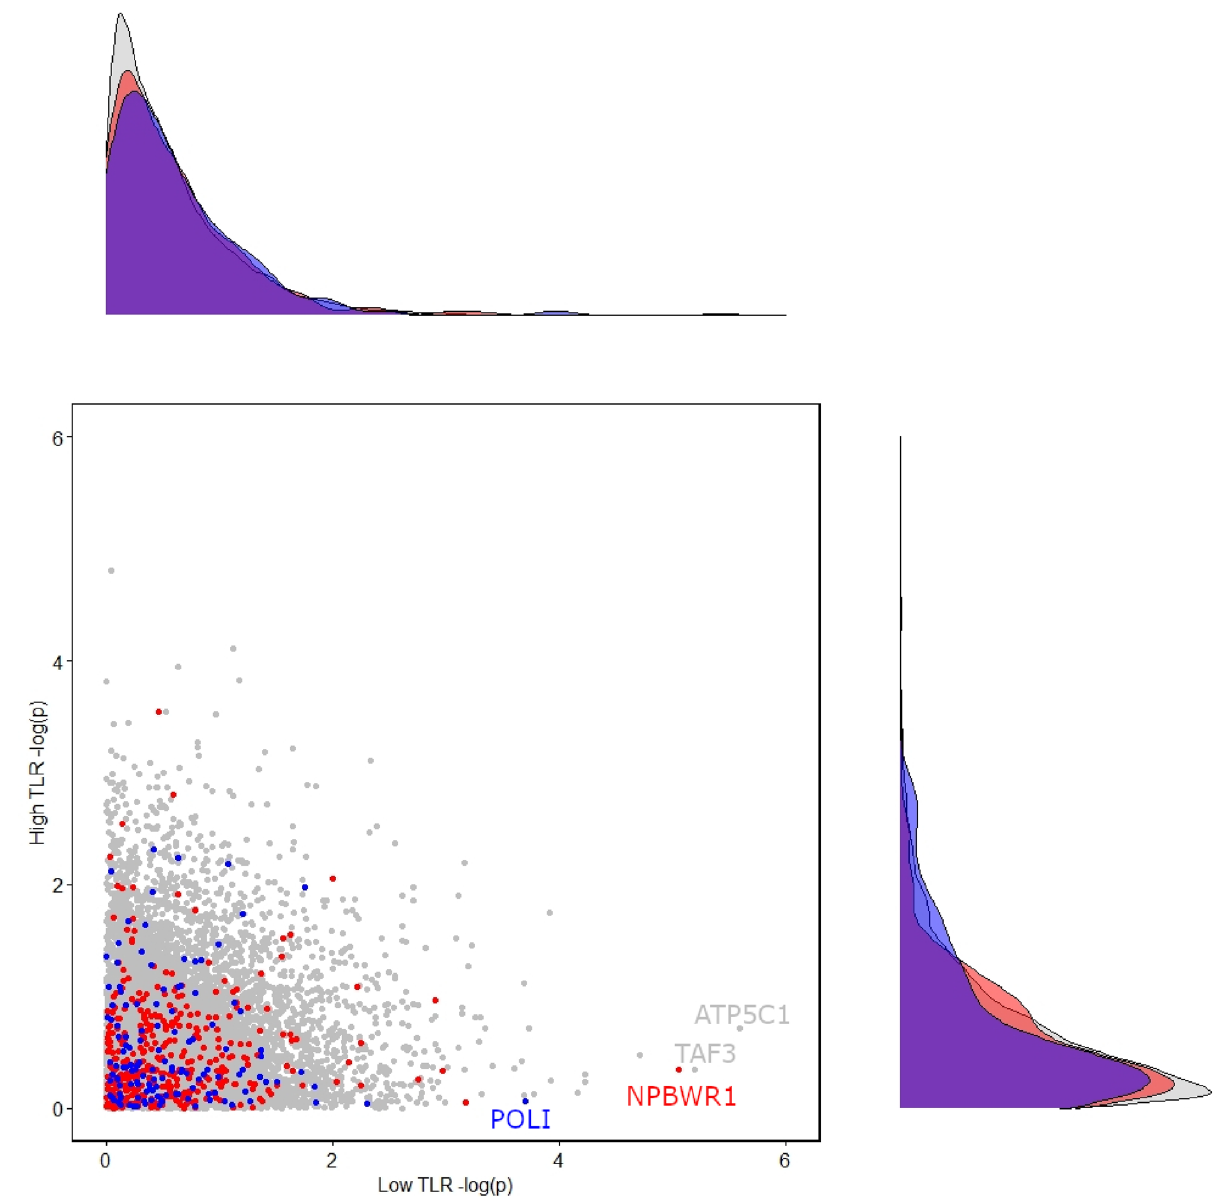
Figure 2. Gene-level association (p-value) scatterplot for depressive symptoms in low versus high dietary TLR subgroups showing kynurenine-related genes in blue, serotonin-related genes in red, and all the other genes in grey on a negative base ten logarithmic scale (− log(p)). ATP5C1 , NPBWR1 and TAF3 genes survived gene-level correction for all genes in the low dietary TLR subgroup. In addition, the POLI gene survived correction for the kynurenine gene-set in the low dietary TLR